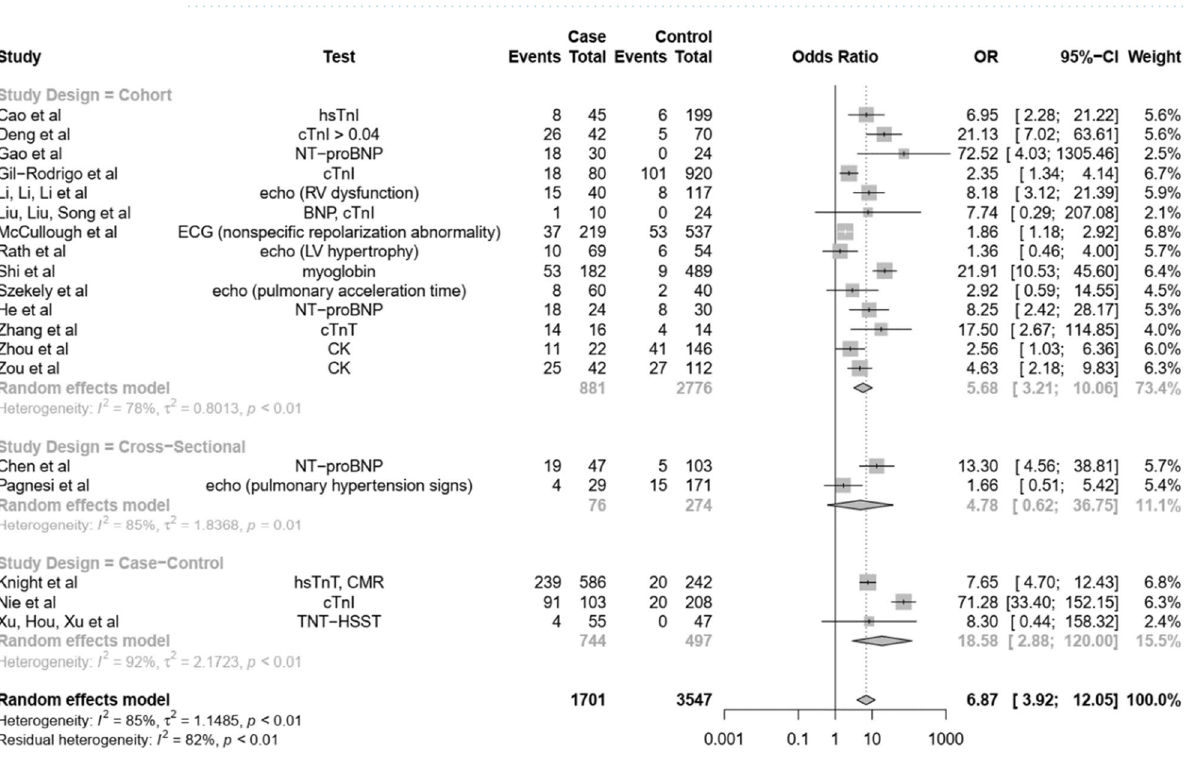
Figure 3. Forest plot of all 19 studies showing the odds ratio (OR) as well as subgroup analyses based on study